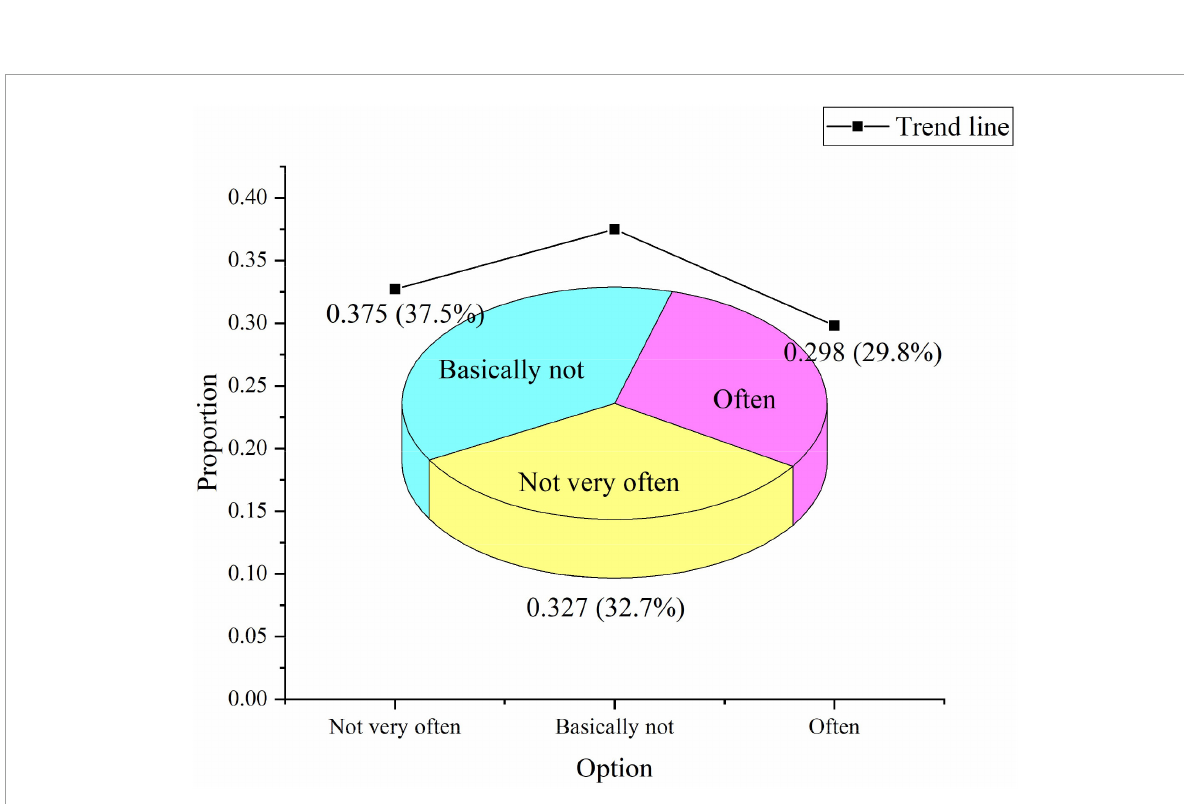
FIGURE11 Investigation of similar activities such as sports culture